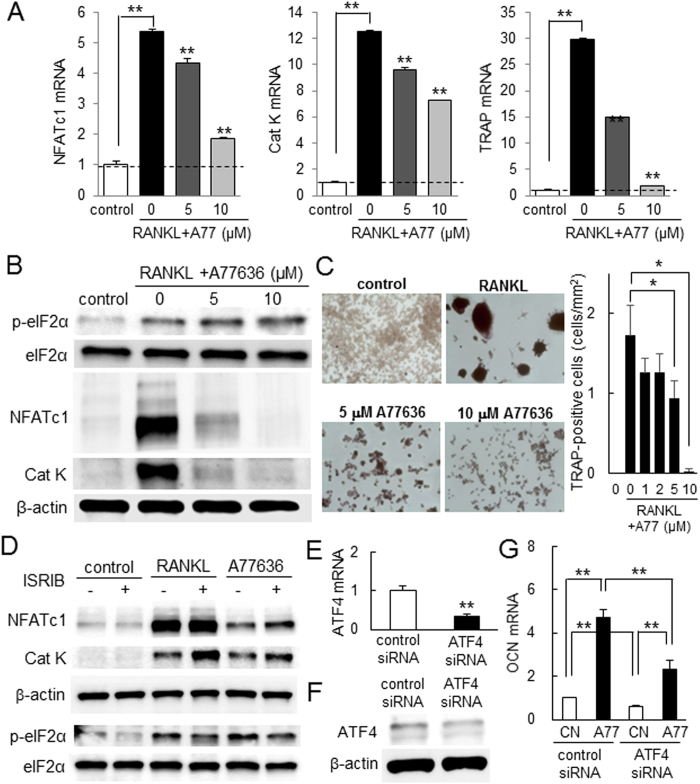
Inhibitory effects of A77636 on development of RAW267.4 pre-osteoclasts.The double asterisk indicates p < 0.05. Of note, A77 = A77636, and CN = control. (A) Decrease in the relative mRNA abundance of NFATc1, Cathepsin K, and TRAP in response to 5 and 10 μM A77363 in RANKL stimulated cells. (B) Downregulation of NFATc1, Cathepsin K, and TRAP proteins in response to 5 and 10 μM A77363 in RANKL stimulated cells. (C) Suppression of TRAP-positive multinucleated cells by 1–10 μM A77636. The number of TRAP-positive cells with 3 or more nuclei was counted. (D) Suppressive effects of ISRIB on A77636-driven downregulation of NFATc1 and Cat K. (E,F) Partial reduction of ATF4 mRNA and ATF4 protein, respectively, with siRNA specific to ATF4. (G) ATF4-mediated upregulation of osteocalcin (OCN) mRNA in response to 10 μM A77636.